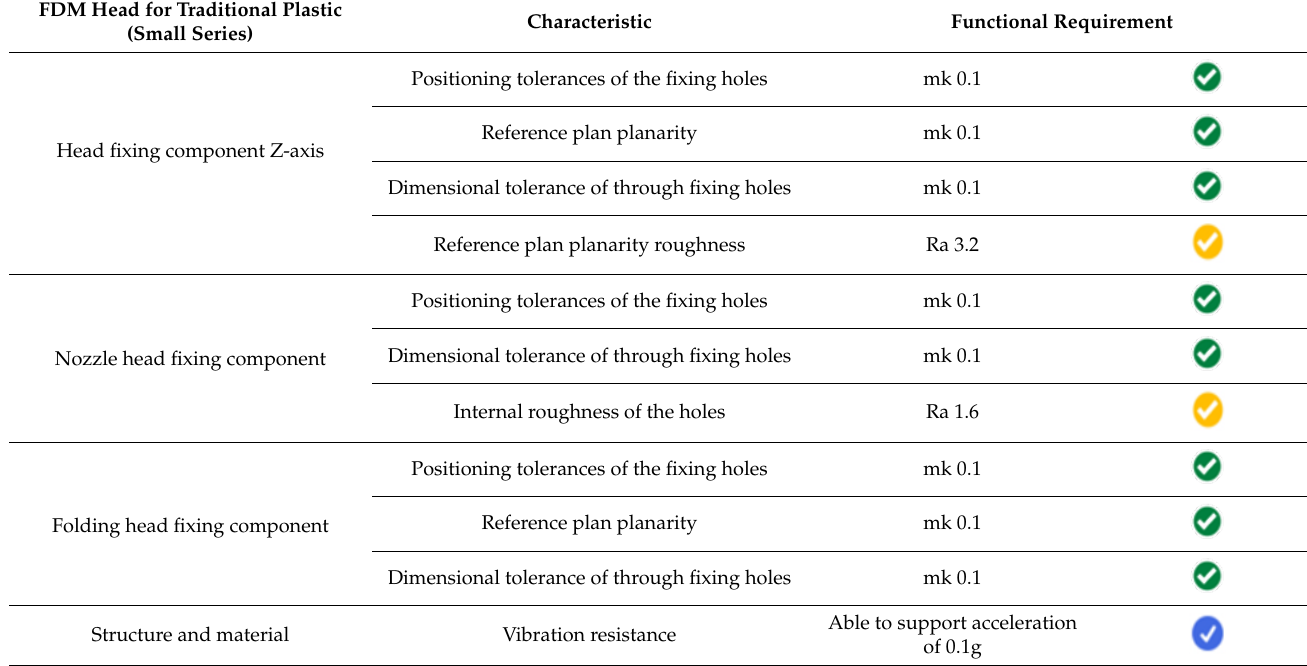
Table 11. Functional requirements verification of the FDM head for traditional plastics. Figure 11. Real component made by SLM (small series).